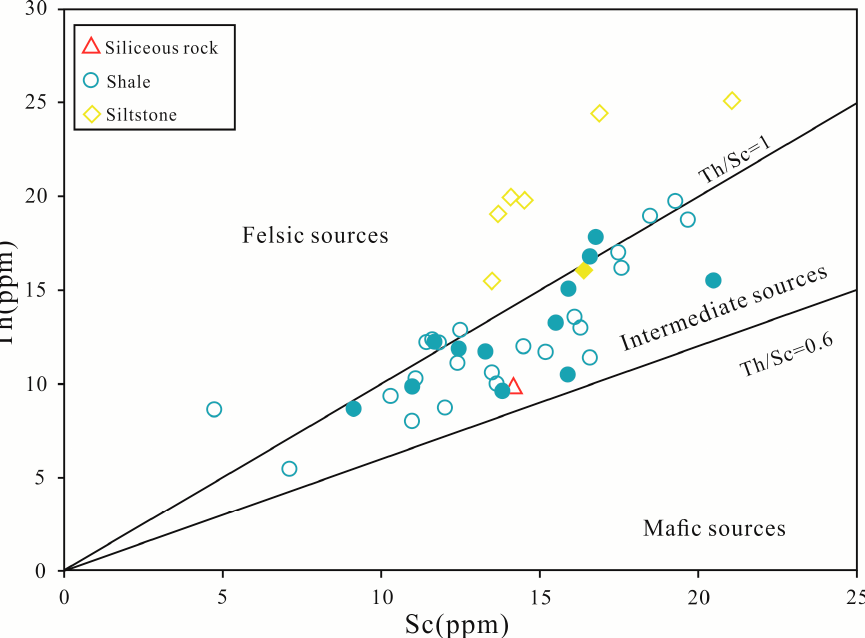
Figure 10. Source discrimination diagrams of Sc vs. Th. Hollow points are the samples from SQ-1 and solid points are the samples from CY-1.